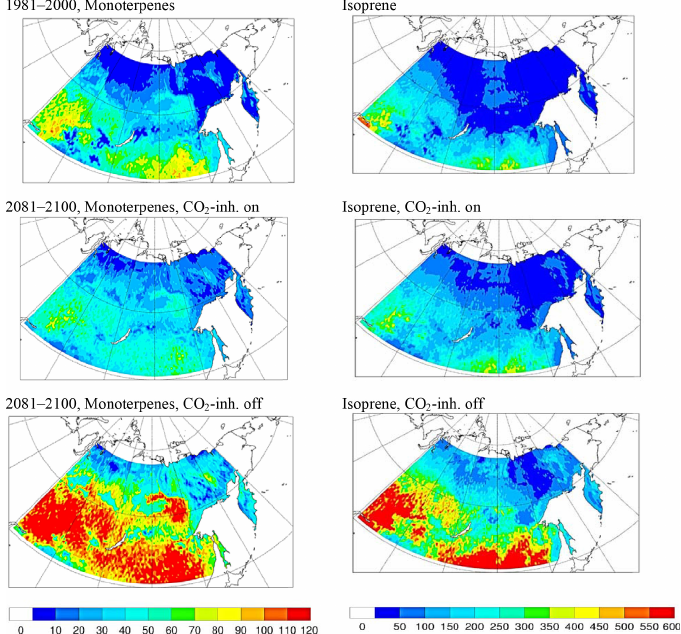
Figure A1. Present-day (top: 1981–2000) and end of 21st century (bottom: 2081–2100) total monoterpene (left) and isoprene (right) emis- sions for the month July (mgCm − 2 month − 1 ) . Future simulations show results with CO 2 inhibition switched on and off; for present-day conditions the CO 2 effect on BVOCs is marginal as the values are close to the standardized concentration of 370ppm, and therefore only the patterns without CO 2 effect are shown.